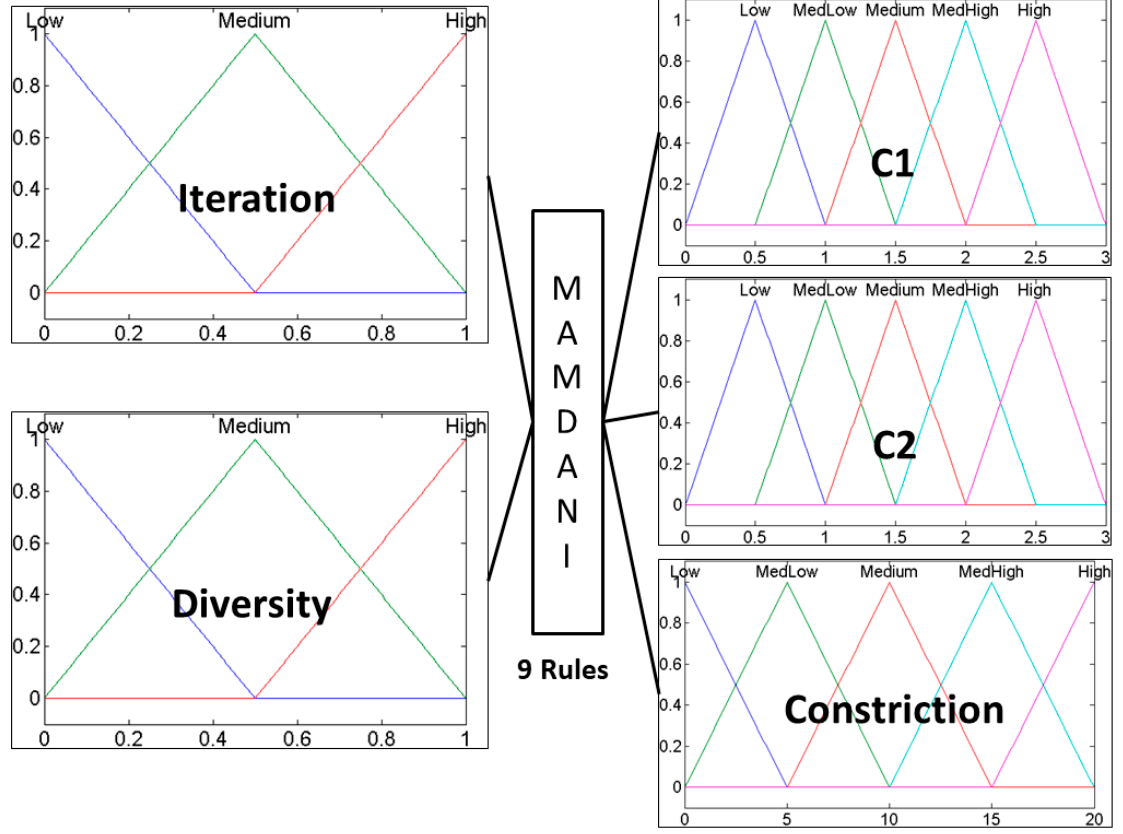
Figure 3. Type-1 fuzzy system for dynamic parameter adaptation in PSO (Particle Swarm Optimization).